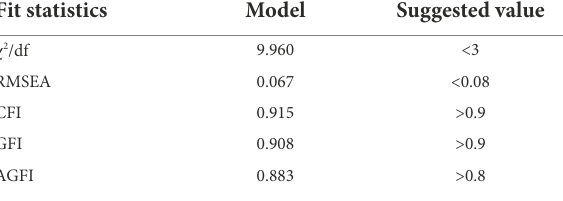
TABLE 5 Model fit